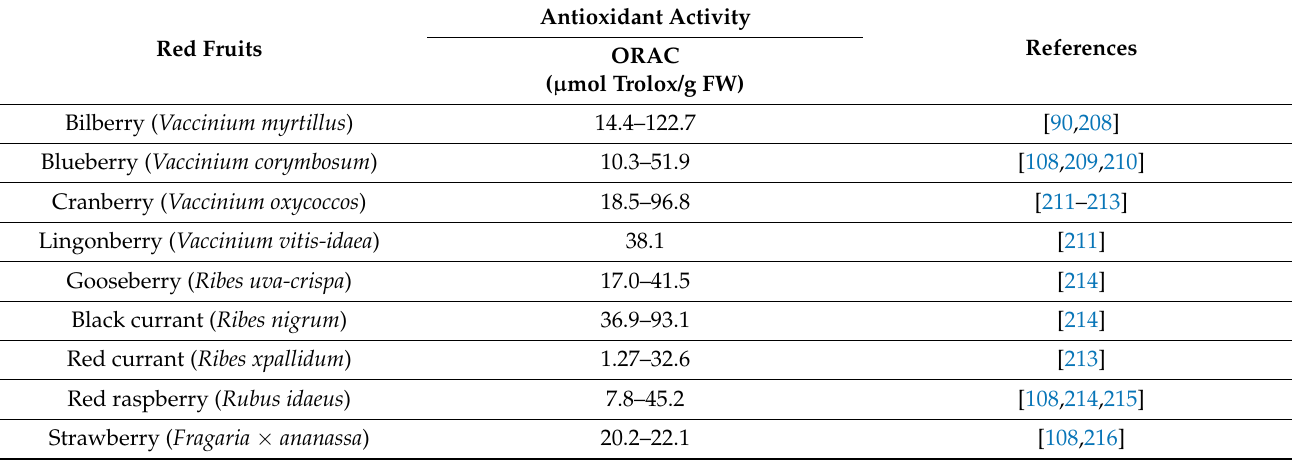
Table 11. Some examples of antioxidant activity values of red fruits by ORAC method.